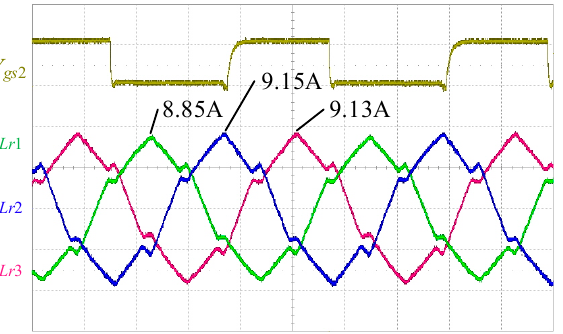
the full load efficiency is 93.74%. All equipment including power source, load, and power Figure 22. ( a ) State-plane analysis result at 50% load ( b ) State-plane analysis result at 100% load. Figure 22. ( a ) State-plane analysis result at 50% load ( b ) State-plane analysis result at 100% load. meter are EA PSB 11000-80, Chroma 63209, and Hioki PW6001.